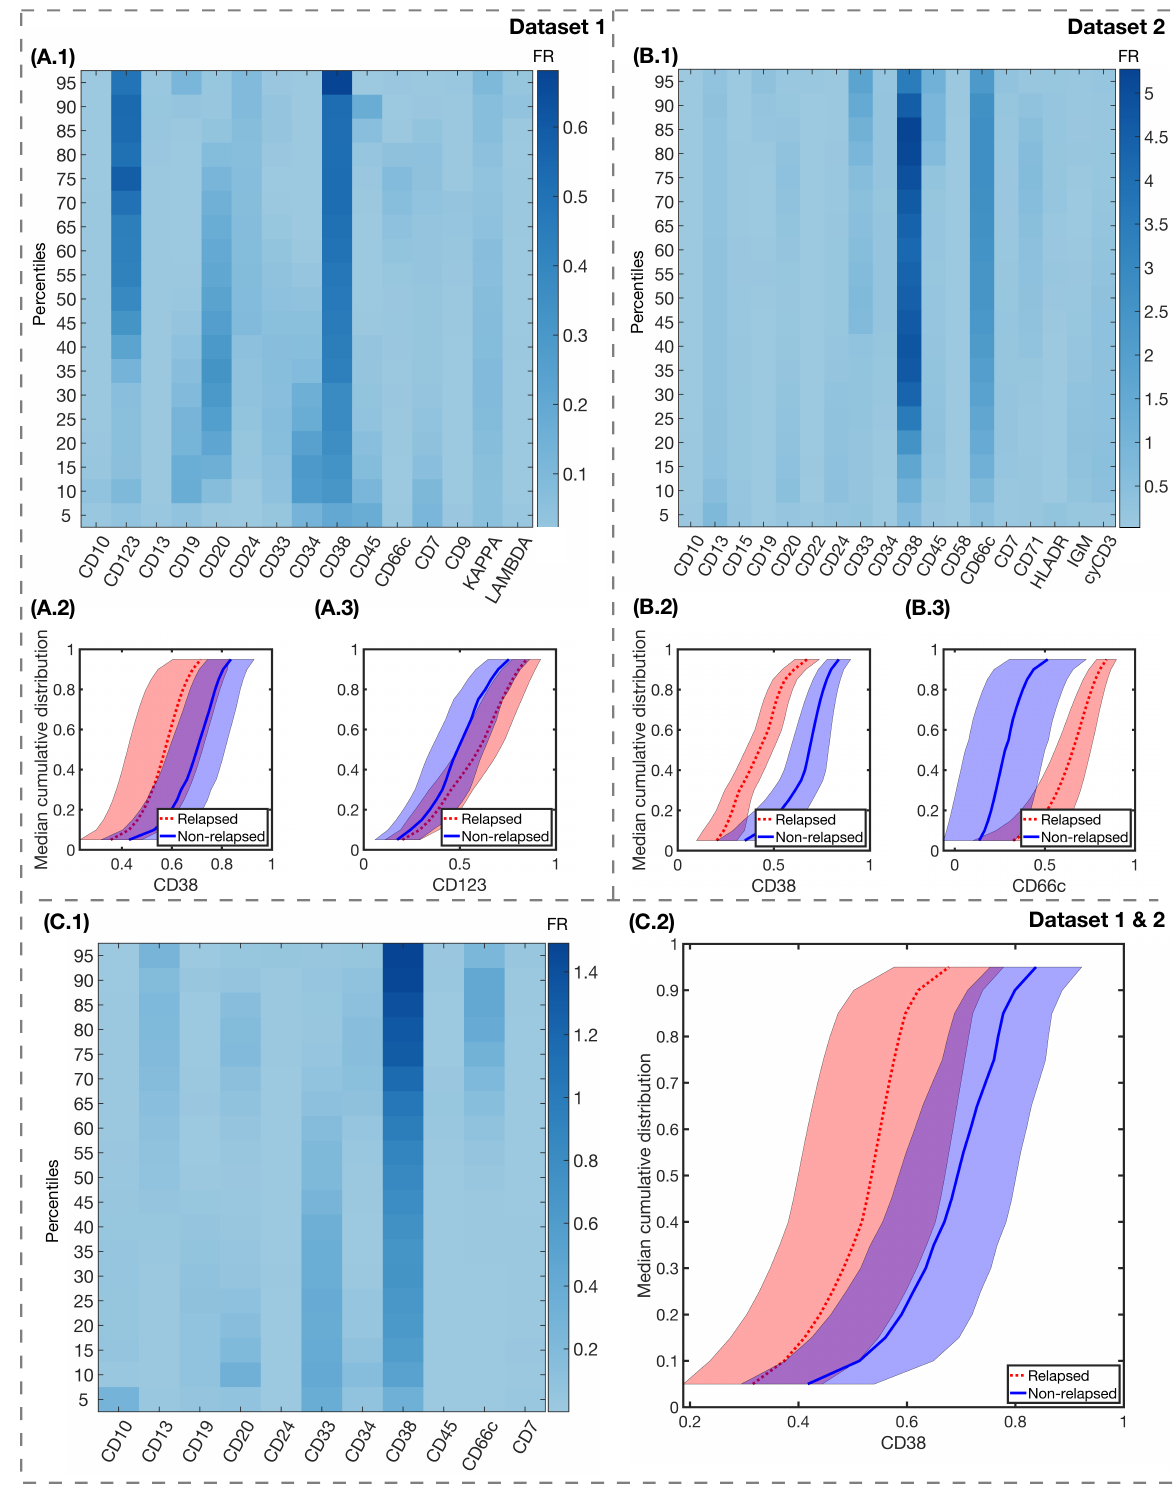
Figure 6. Fisher’s Ratio analyses and median cumulative distributions of markers with highest FR. Fisher’s Ratio Matrices for Dataset 1 ( A.1 ), Dataset 2 ( B.1 ), and both datasets combined ( C.1 ). The common parameters within each dataset are represented in the x-axis, while in the y-axis we represent the percentiles of the median cumulative distribution. Colorbars show the intensity of the Fisher’s Ratio for each percentile and marker. Median cumulative distributions and standard deviation bands of the IPT markers with highest FR, for relapsed (red, dotted lines) and non-relapsed (blue, solid lines) patients are represented in the following charts: for Dataset 1, CD38 ( A.2 ) and CD123 ( A.3 ); for Dataset 2, CD38 ( B.2 ) and CD66c ( B.3 ); and, for both datasets combined, CD38 ( C.2